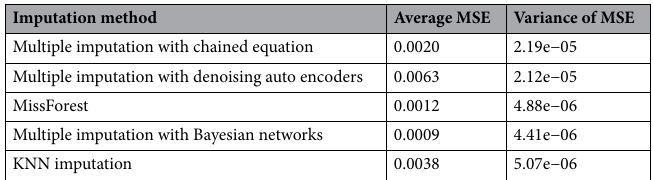
Table 2. The average and variance of the mean squared error for estimating excluded values of the CBC variables using different imputation